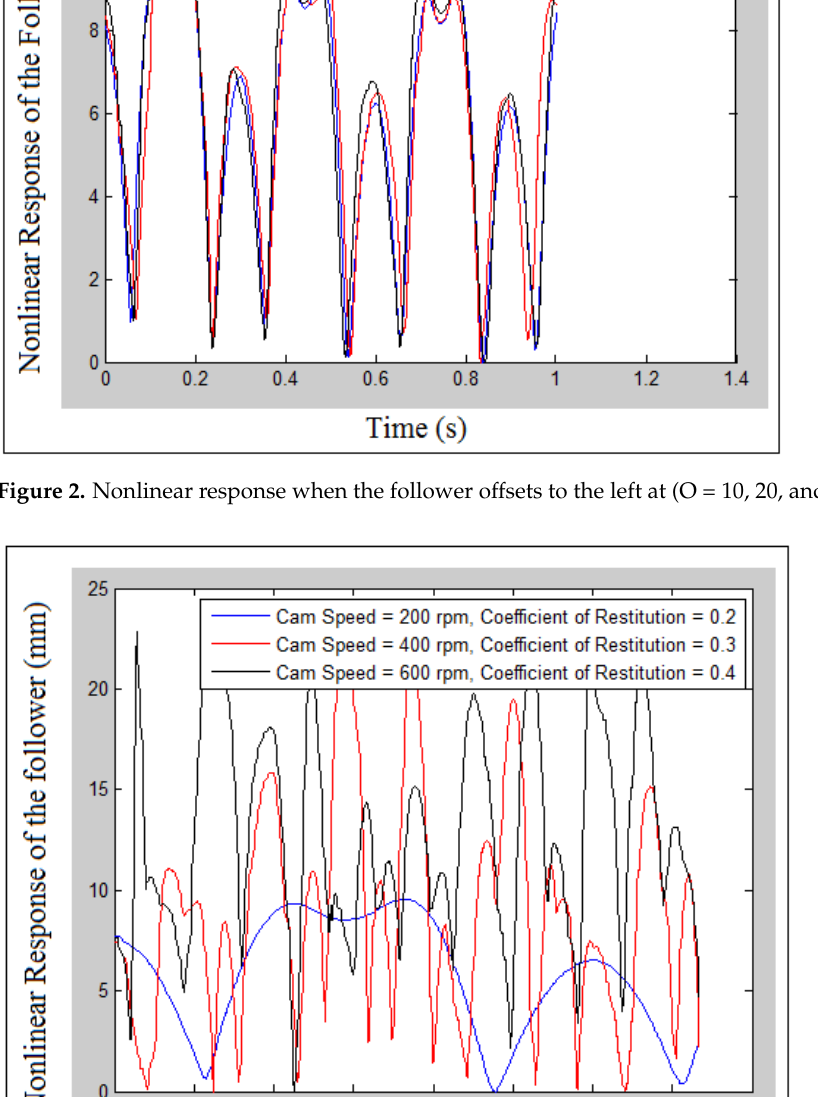
Figure 2. Nonlinear response when the follower offsets to the left at (O = 10, 20, and 30 mm).